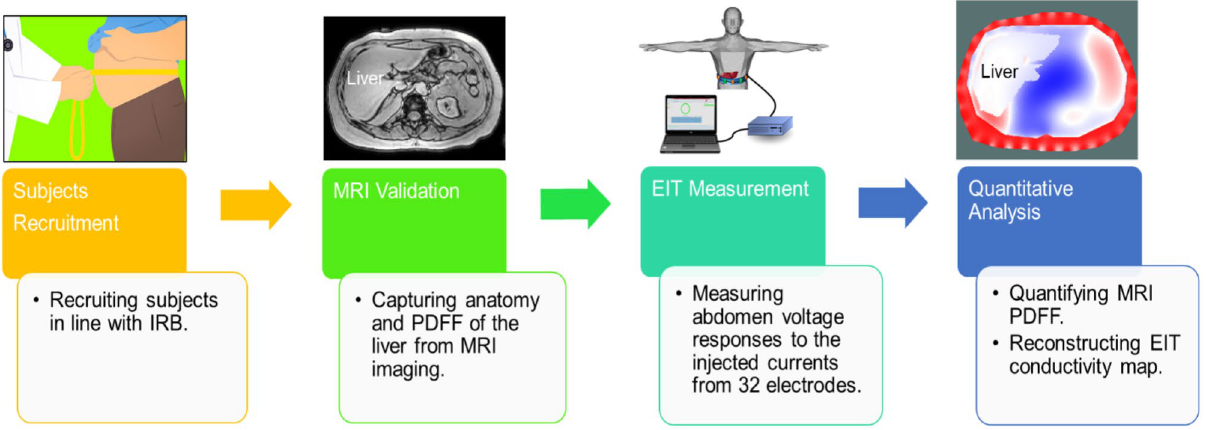
Figure 1. Schematic workflow of the comparison and validation of the MRI and EIT. Volunteers were recruited in line with the UCLA Institutional Human Subjects Protection Committee. Multi-echo MRI scans were performed to provide the liver anatomy and proton density fat fraction (PDFF), followed by the EIT measurements. Finally, the EIT conductivity maps were reconstructed and the MRI PDFF was used to quantify fatty liver infiltrate and to compare with EIT liver